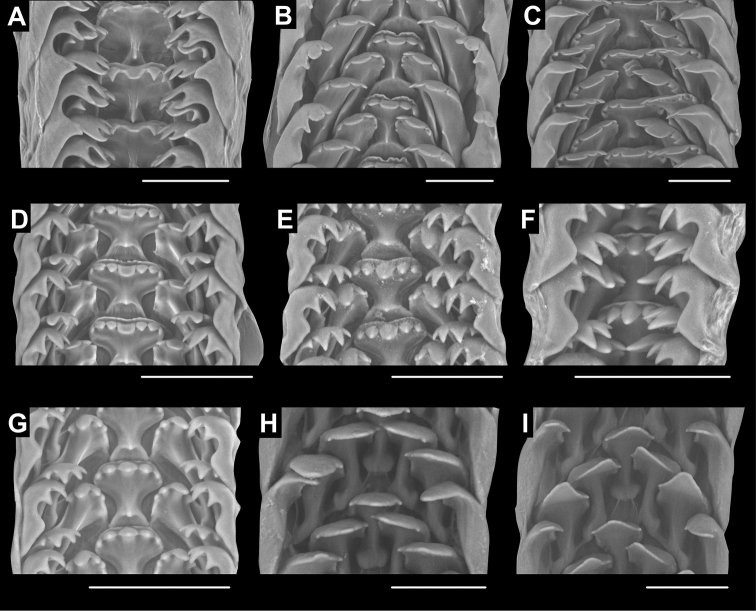
Radulae of AlycaeidaeAAlycaeus
eydouxi Venmans, 1956 NHMUK 20160702 BAlycaeus
gibbosulus Stoliczka, 1872, HNHM 104857 CDioryx
messageri (Bavay & Dautzenberg, 1900) NHMUK 2014.02.81 DChamalycaeus sp., HNHM 104858 EChamalycaeus
everetti (Godwin-Austen, 1889), HNHM 104859 FDicharax
itonis (Kuroda, 1943) HNHM 104860 GDicharax
okinawaensis (Uozumi, Yamamoto & Habe, 1979), HNHM 104431 HStomacosmethis
balingensis (Tomlin, 1948) HNHM 104861 IStomacosmethis
perakensis (Crosse, 1879) HNHM 104430. Scale bars: 50 μm. All images: Barna Páll-Gergely.